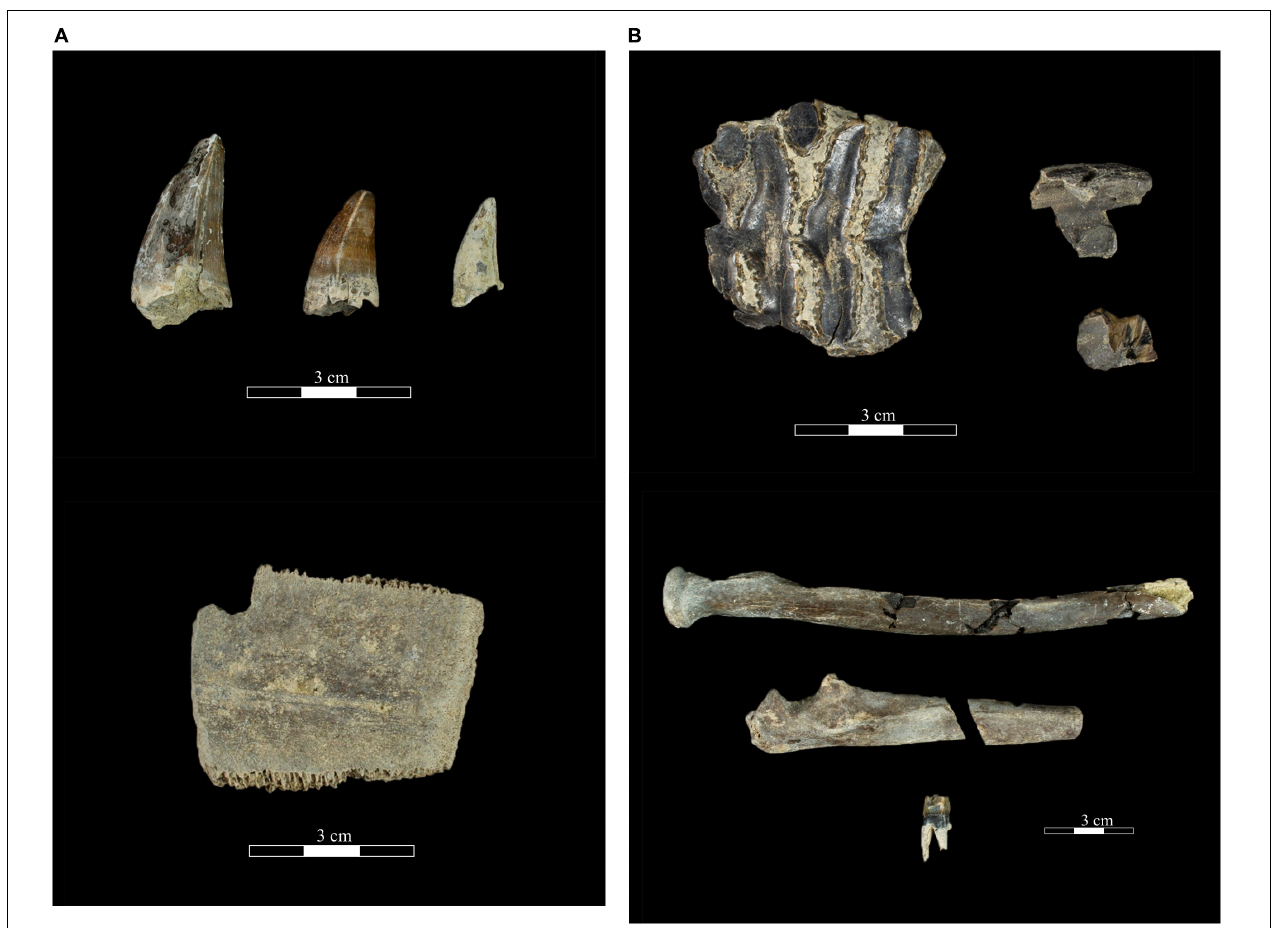
FIGURE 8 | Specimens recovered expressing diversity in the Ewass Oldupa assemblage. (A) Crocodylus sp. Teeth and Chelonia sp. plastron fragment with puncture mark. (B) Occlusal view of tooth belonging to Proboscidae indet.p and Theropithecus oswaldi ulna, radius and